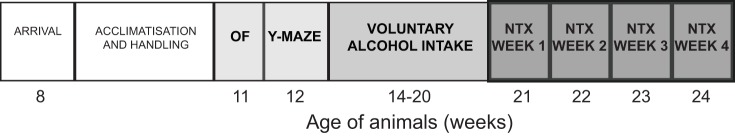
The experimental outline. The rats were allowed to acclimatize to the animal facility and the reversed light/dark cycle for 2 weeks and adapted by daily handling. Thereafter, the animals were tested in the open field (OF) followed by the Y-maze and then given intermittent access to alcohol and water in the home cage on 3 consecutive days per week for 6 weeks. Subsequently, over the next 4 weeks naltrexone (NTX) and saline were administered in a Latin square design 30 min prior to alcohol access and intake was measured at 30 min, 2 h, and 24 h.